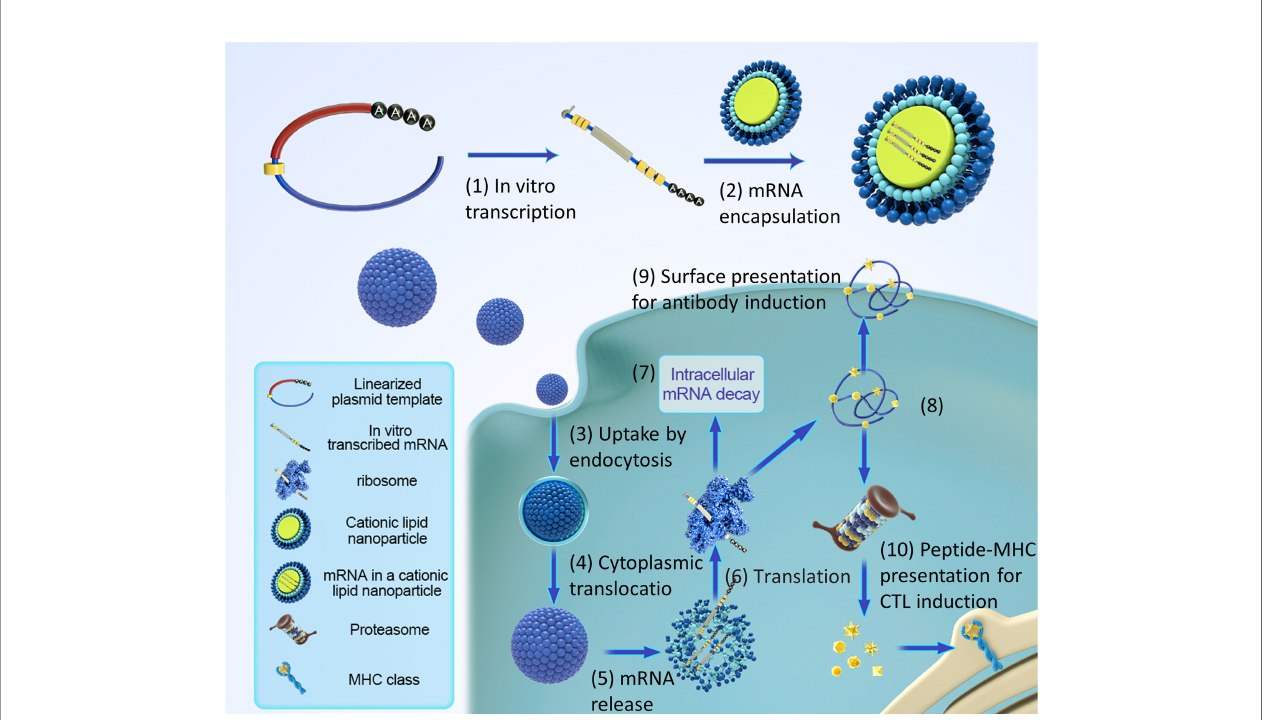
FIGURE 3 | Pharmacology principles of antigen-encoding mRNA. (1) In vitro transcription using linearized DNA plasmid templates with antigen coding sequences. The in vitro transcribed mRNA contains the structures: cap, 5 ′ and 3 ′ untranslated regions (UTRs), the open reading frame (ORF), and the poly(A) tail. (2) The synthesized mRNA was compounded with cationic liposomes to form an mRNA-LNP complex. (3) Liposomes protect mRNA from RNase degradation and facilitate cellular uptake of mRNA. (4) Release of the mRNA-LNP complex in the cytoplasm. (5) Release of mRNA from liposome complex. (6) mRNA is translated using the host cell ’ s protein synthesis machinery. (7) terminates translation by mRNAs degradation catalyzed by an external ribozyme. (8) the post-translational modi fi cation of the translated protein product depends on the nature of the host cell. (9) protein-derived epitopes can be presented by MHCI and MHCII molecules on the cell surface. (10) the antigenic peptide epitopes degraded by protein products were loaded on the major histocompatibility complex (MHC) and presented to cytotoxic T lymphocytes.